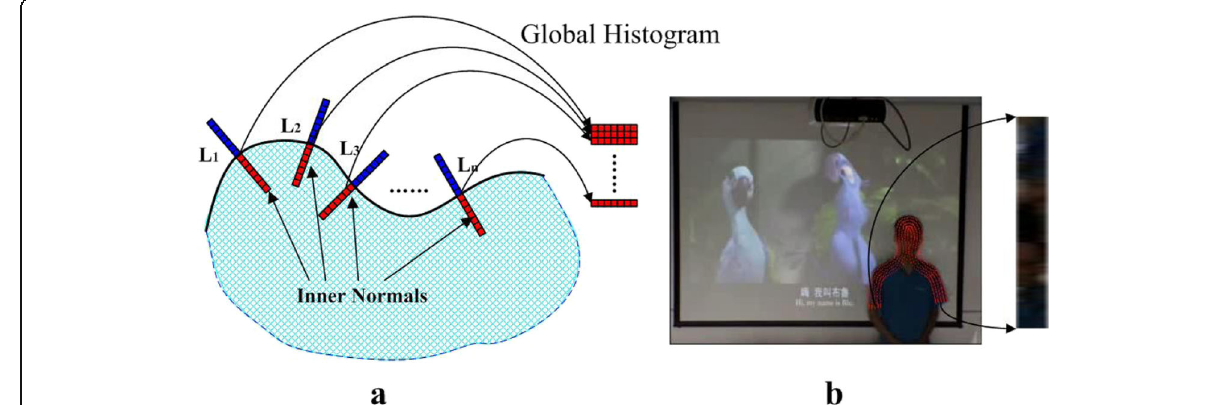
Fig. 3 Global histogram of inner normals